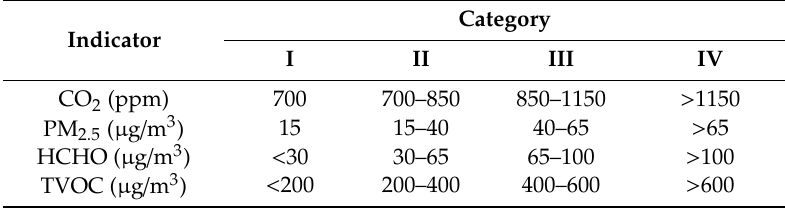
Table 2. Parameter limit values for the indoor environmental quality